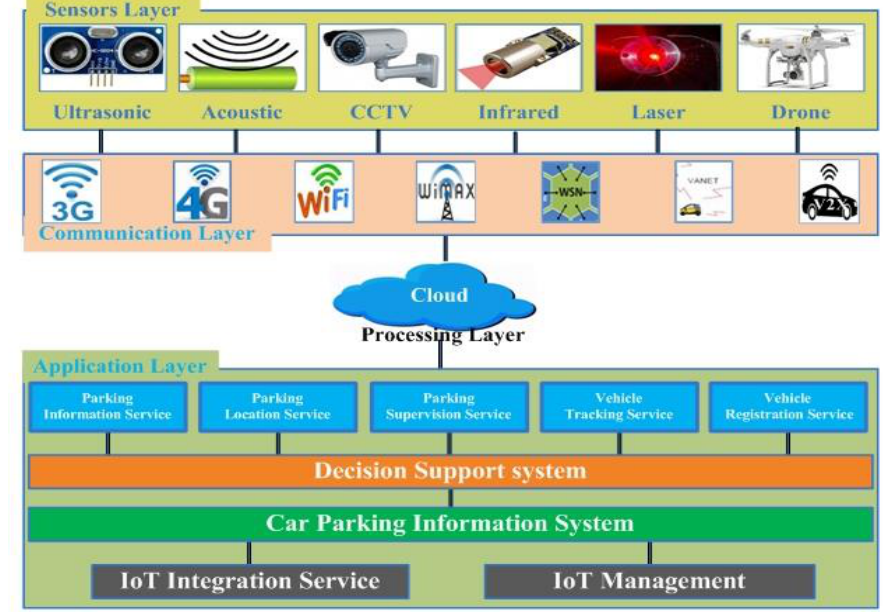
Figure 1. Internet of Things (IoT) based smart parking system use case diagram.